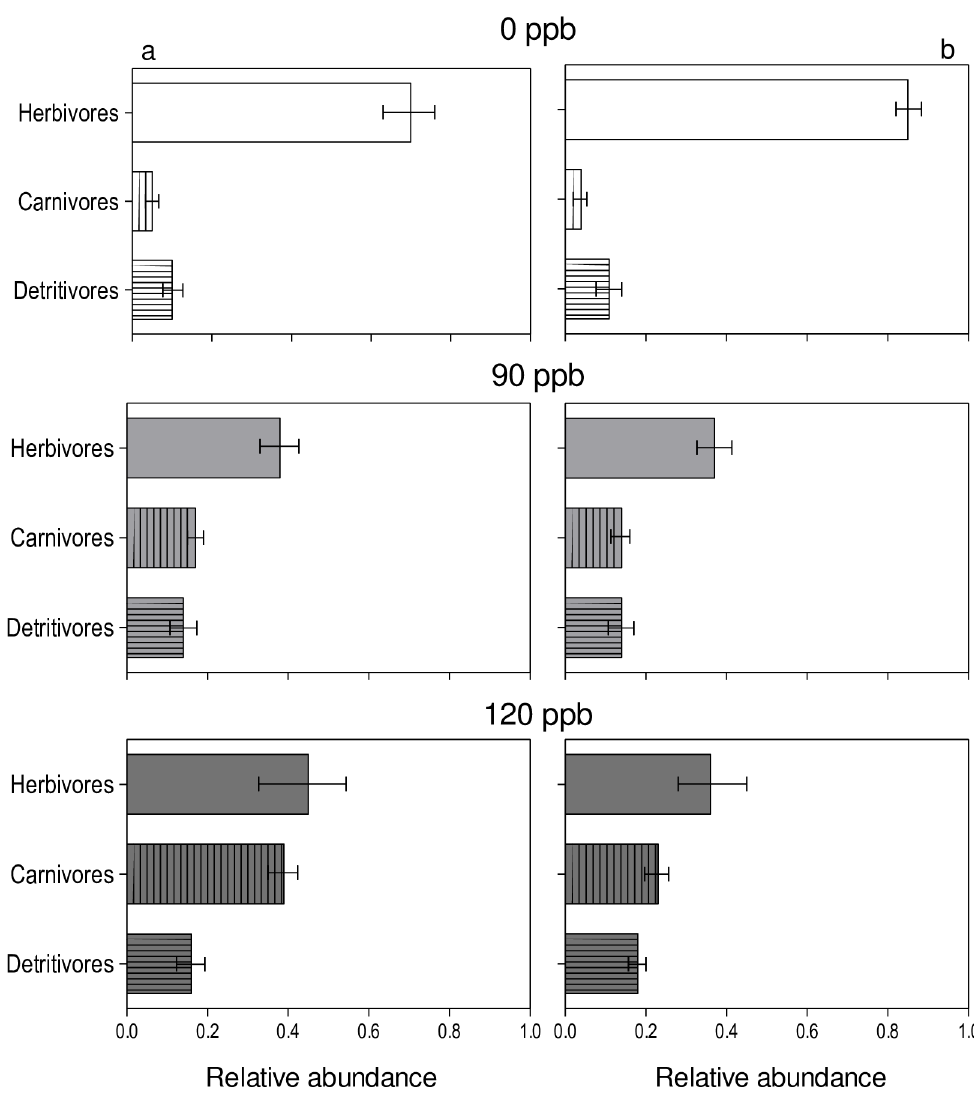
Fig 2. Relative abundance of arthropods corresponding to different functional groups colonizing field plots originated from plant communities selected under different episodic concentrations of tropospheric ozone. Ozone concentrations in the opentop chambers duringlong-term exposurewere 0 ppb (white bars), 90 ppb (grey bars) and 120 ppb (dark bars). Data represents arthropodabundances duringthe first (a) and second (b) year of experiment, after originalsoil seed bank was transplantedto a common natural field environment. Arthropods were assignedto different groups(guilds) accordingto larval feedingstrategy. Relative abundance for each guild was calculatedas the summed abundances of insects of that guild for a particularyear/ total numberof insects recordedin the plot (n = 3). Error bars represent standard error. Year a ANOVA P guild < 0.01, P ozone 0.03, P guild x ozone 0.021; year b ANOVA P guild 0.02, P ozone 0.014, P guild x ozone 0.07